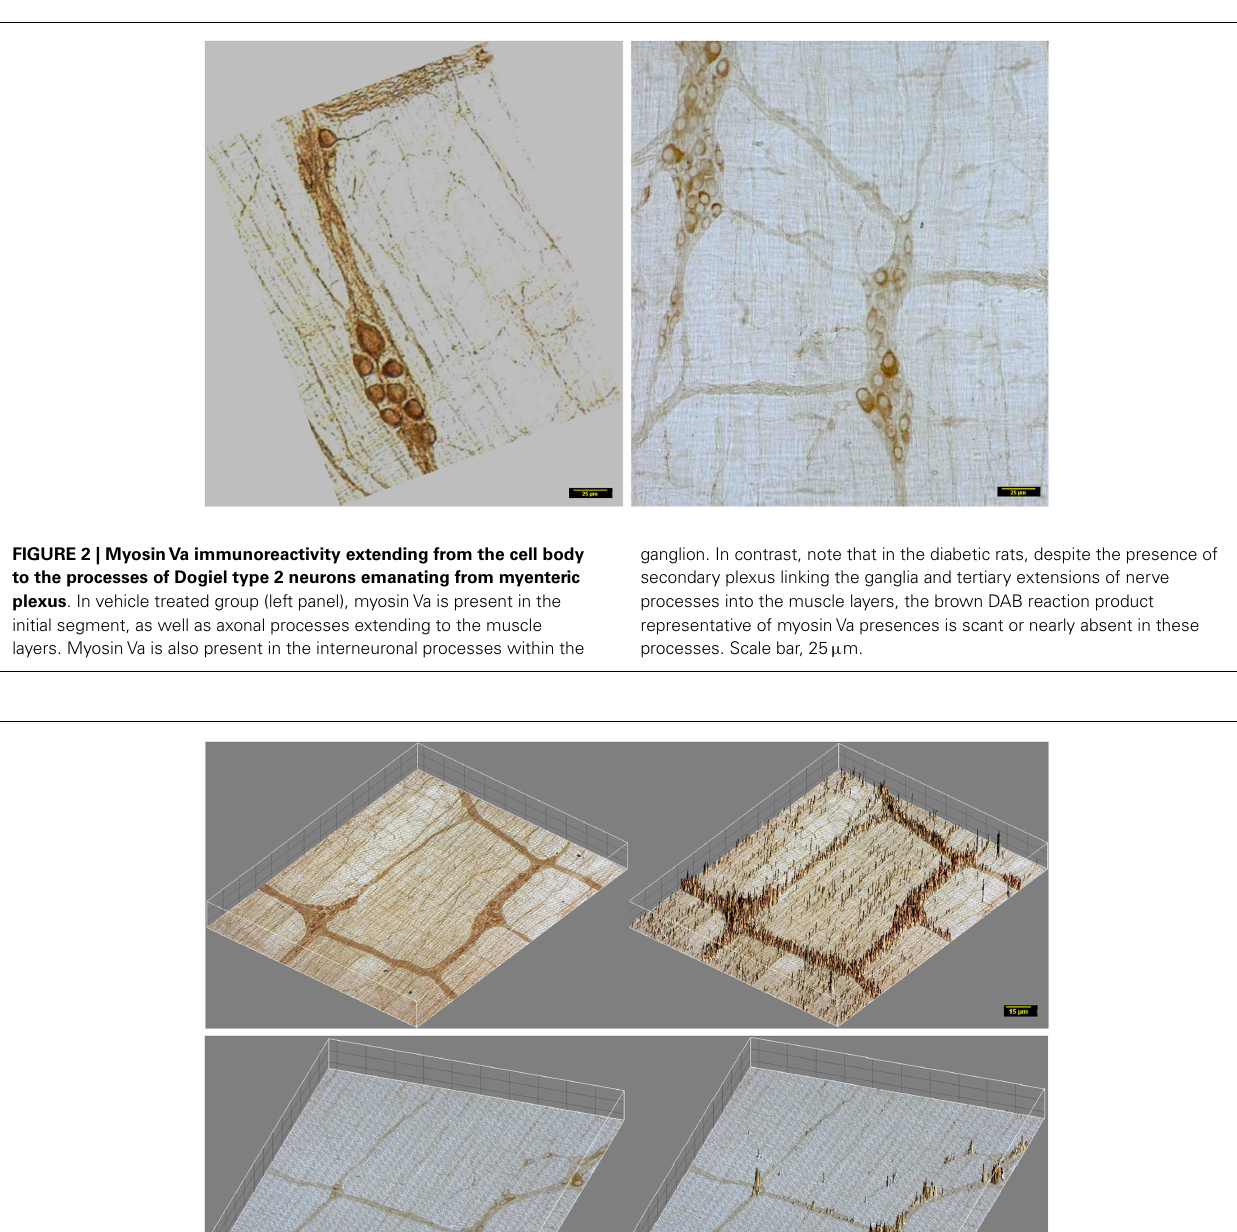
diabetic tissues (lower panels).These nerve terminals are the sites of neuro-smooth muscle neurotransmission. Note the lighter hue of the staining spikes within the neuronal cell bodies, representative of reduction in myosin Va genomic expression within the neuronal soma in diabetic tissues in comparison to vehicle treated rats. Scale bar, 15 µ